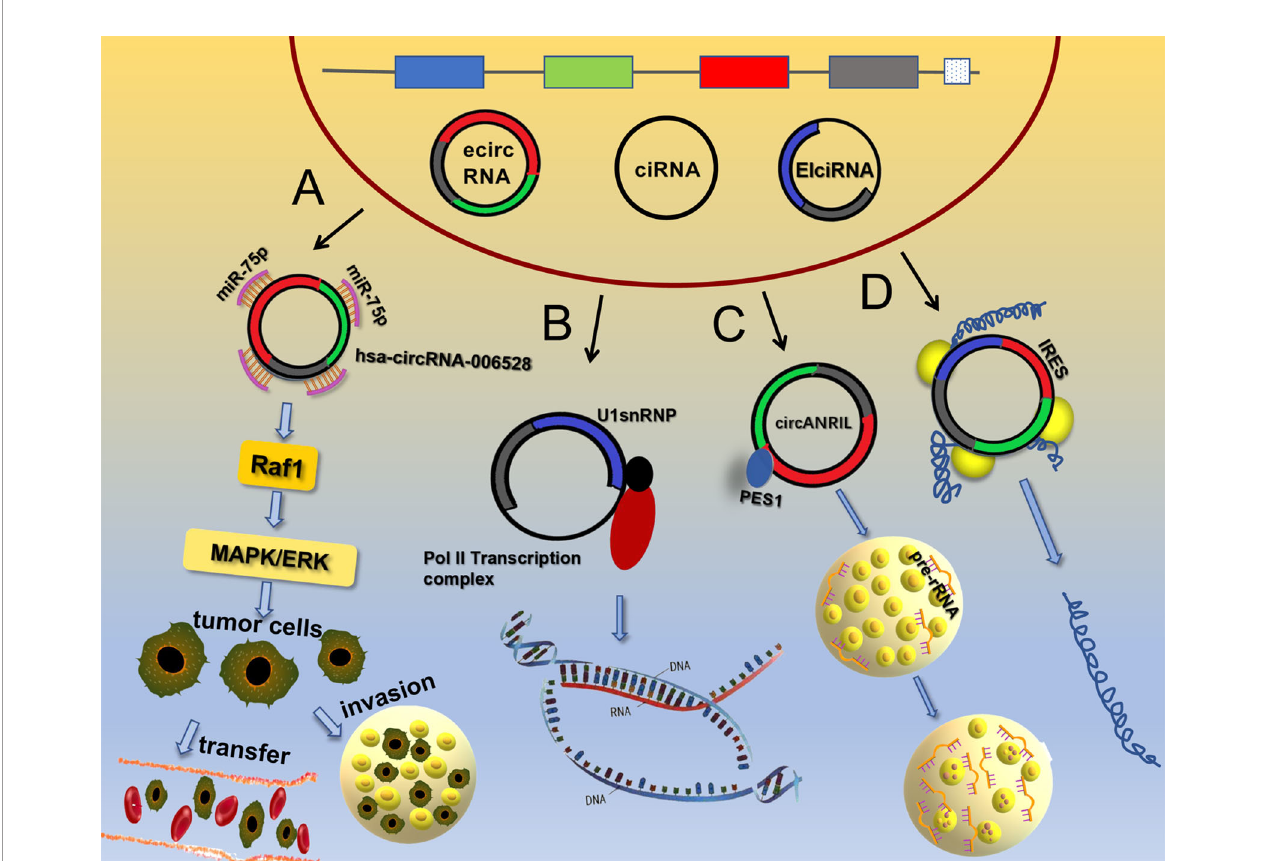
FIGURE 1 | Main functions of circRNAs. (A) CircRNAs can adsorb miRNAs to activate signaling pathways. (B) EIciRNA and U1 snRNP form a complex that interacts with the RNA Pol II complex to regulate gene transcription. (C) Circ-ANRIL binds to PES1 protein to increase the number of cell nucleoli and pre-rRNA accumulation, thereby promoting apoptosis. (D) CircRNAs can be translated into protein through an